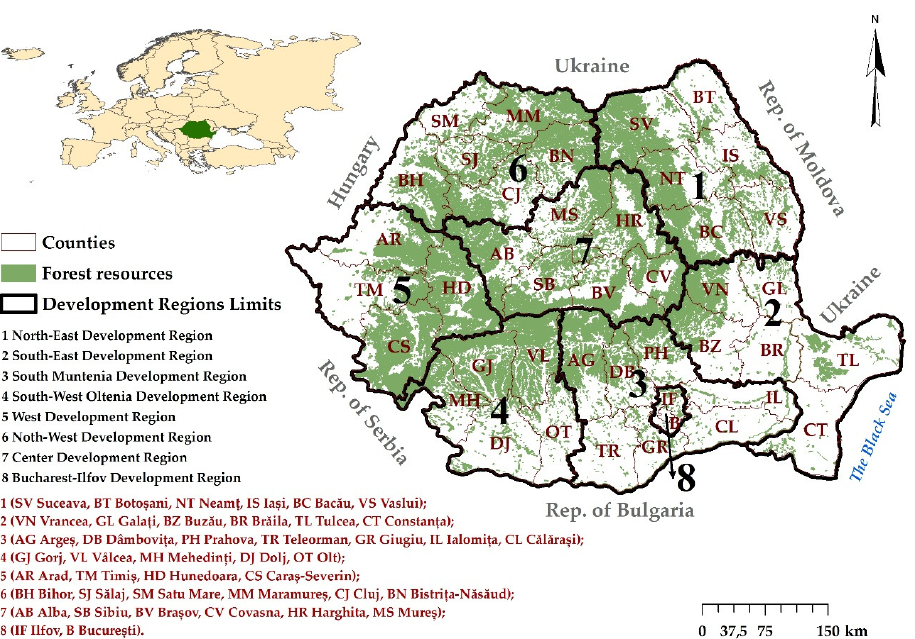
Figure 1. Geographical study area by outlining the development regions in Romania.